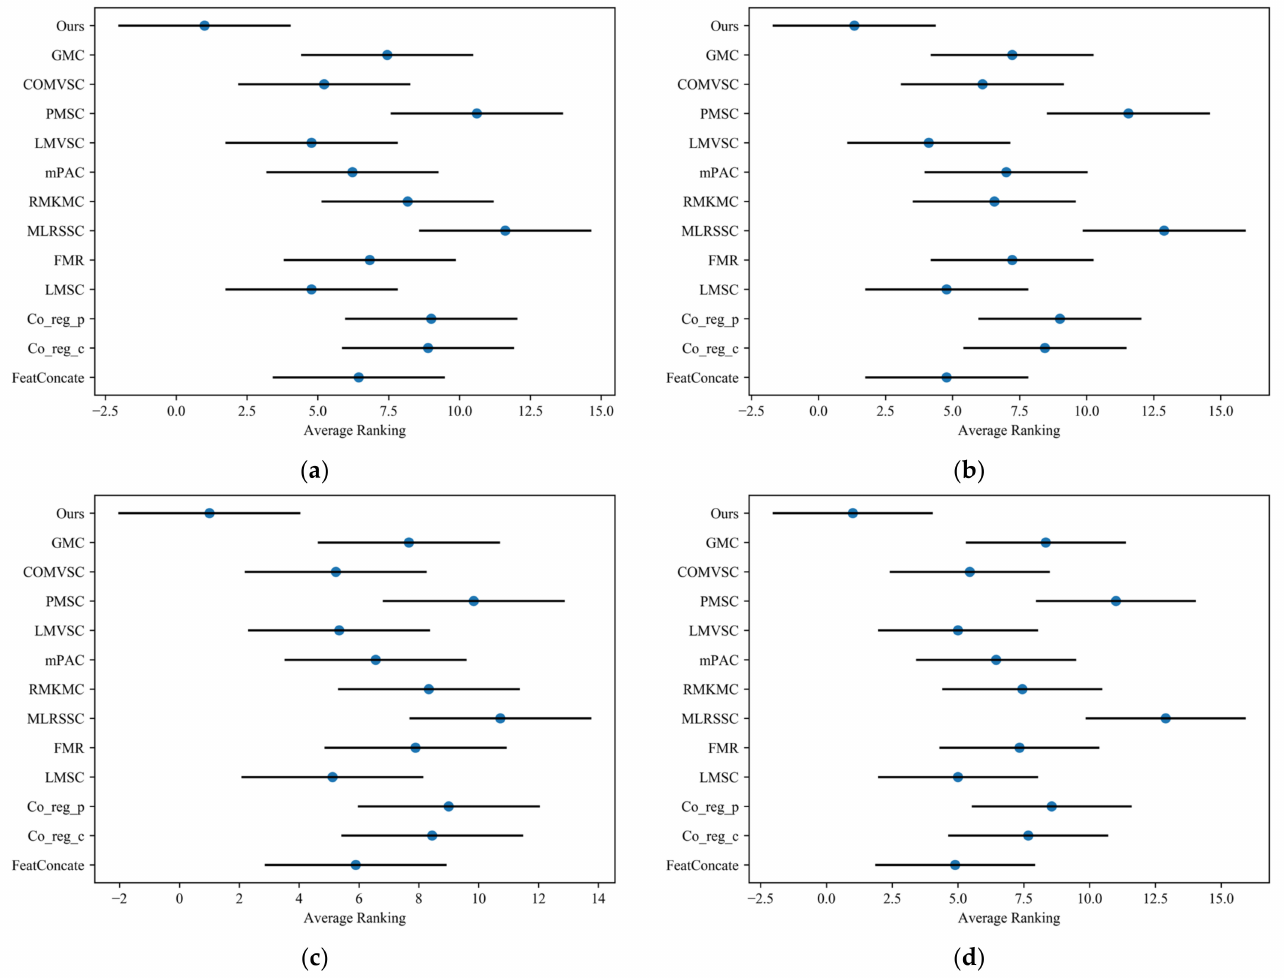
Figure 2. Friedman test charts. ( a ) Friedman test on ACC, ( b ) Friedman test on NMI, ( c ) Friedman test on F-score, ( d ) Friedman test on